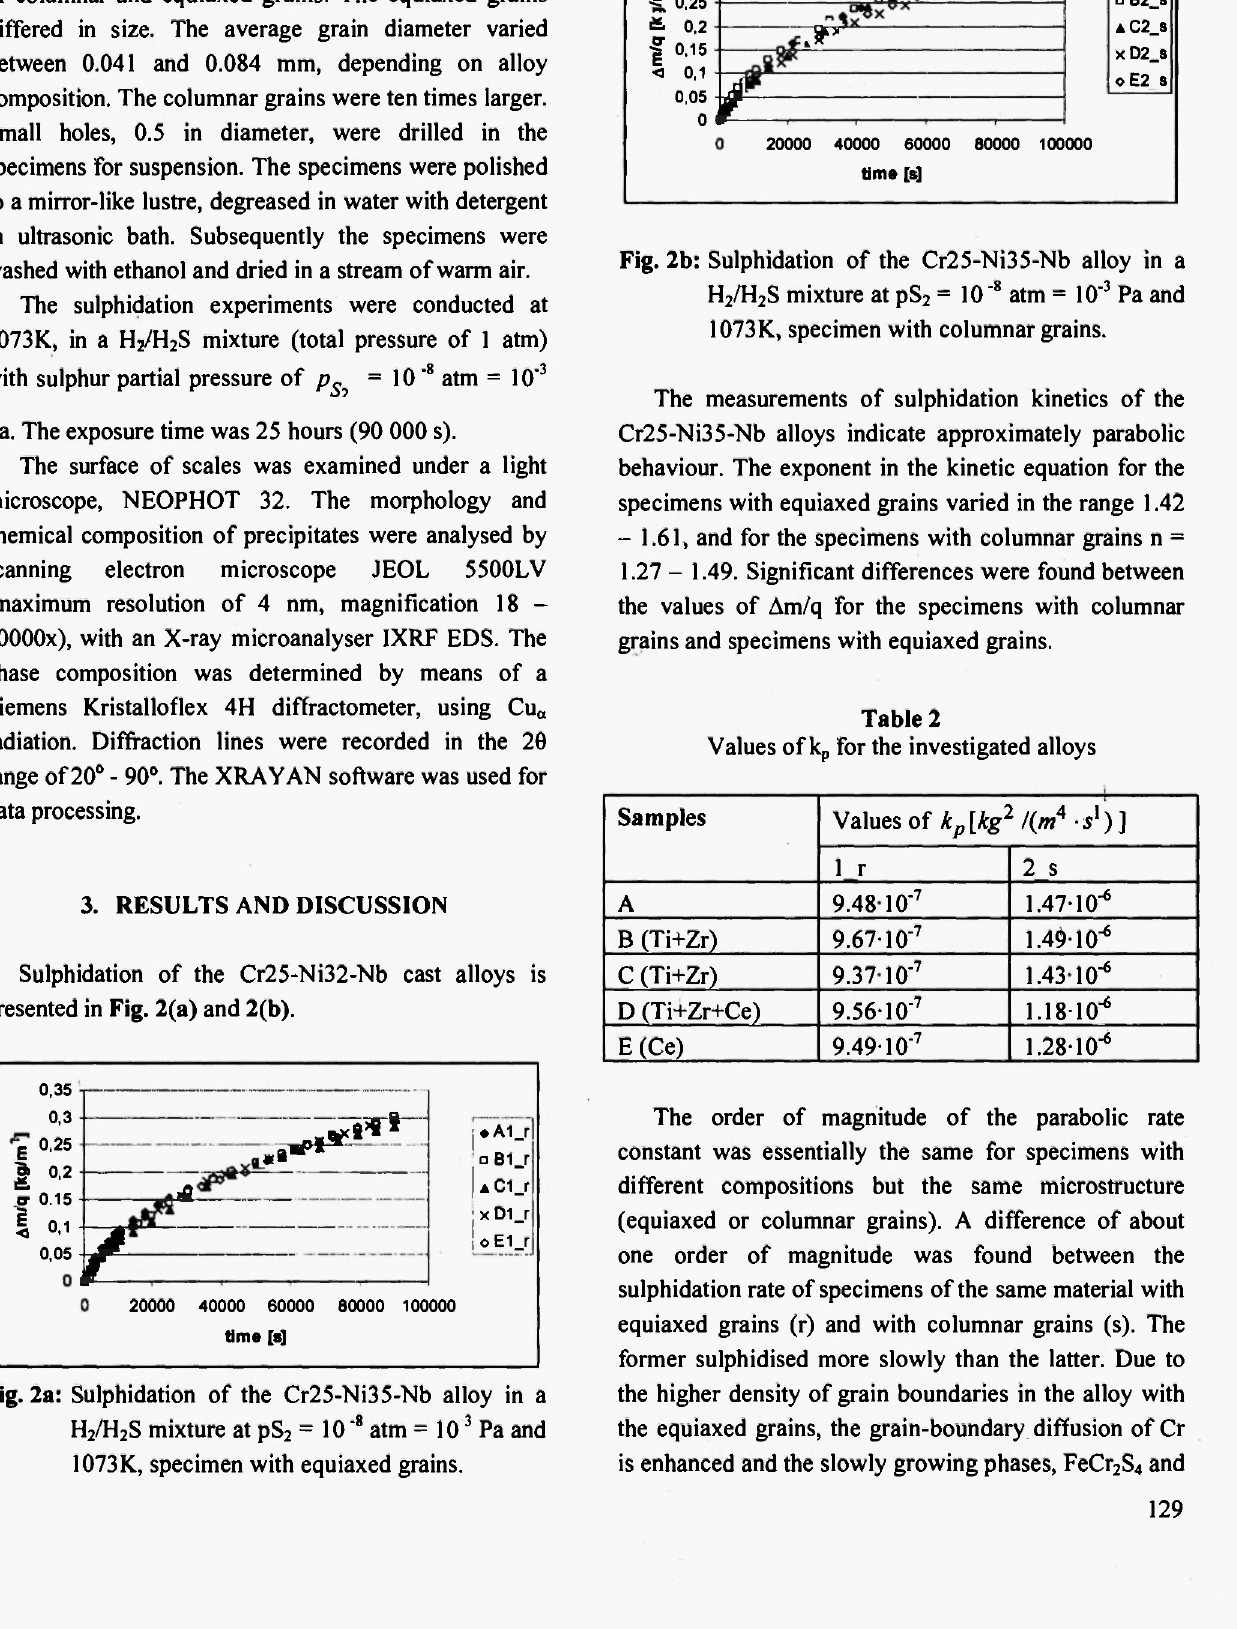
Fig. 2b: Sulphidation of the Cr25-Ni35-Nb alloy in a H 2 /H 2 S mixture at pS 2 = 10 8 atm = 10" 3 Pa and 1073K, specimen with columnar grains.